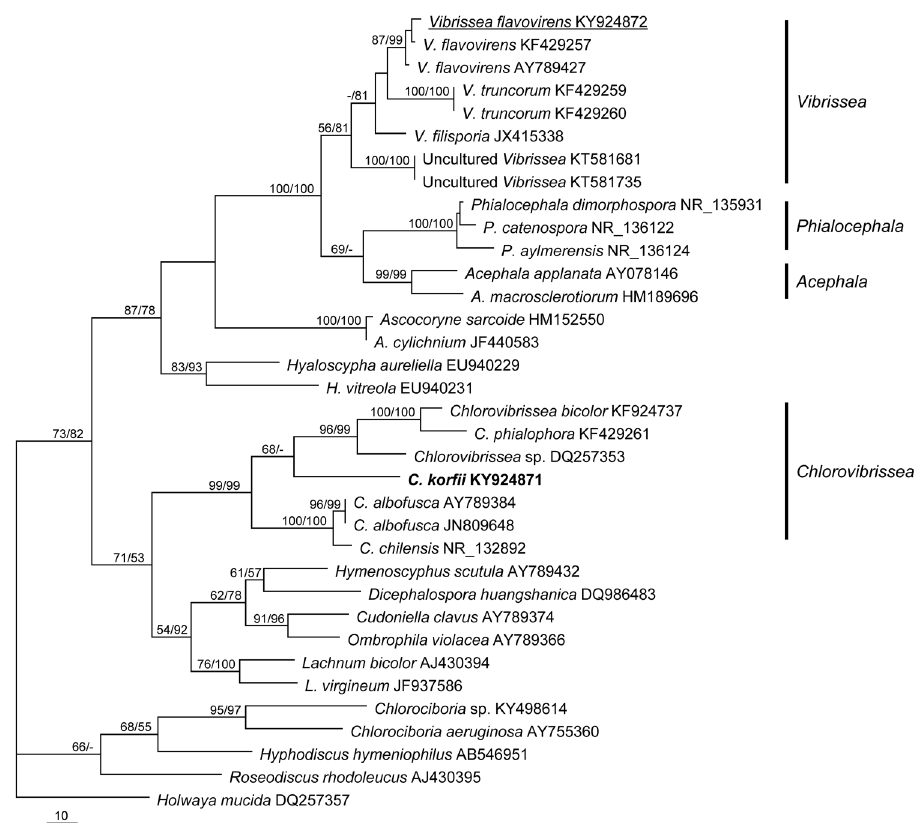
Figure 1. Phylogenetic affinity of Chlorovibrissea korfii and Vibrissea flavovirens inferred from maximum parsimony analysis of ITS sequences. Bootstrap values (≥50%) of MP and NJ are shown at nodes from left to